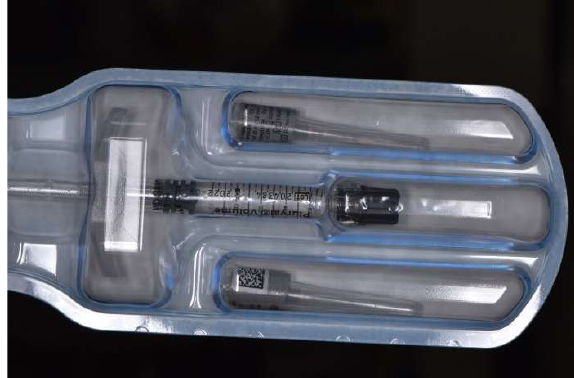
Figure 4. Packaging mode of the pre-filled syringe of hyaluronic acid.